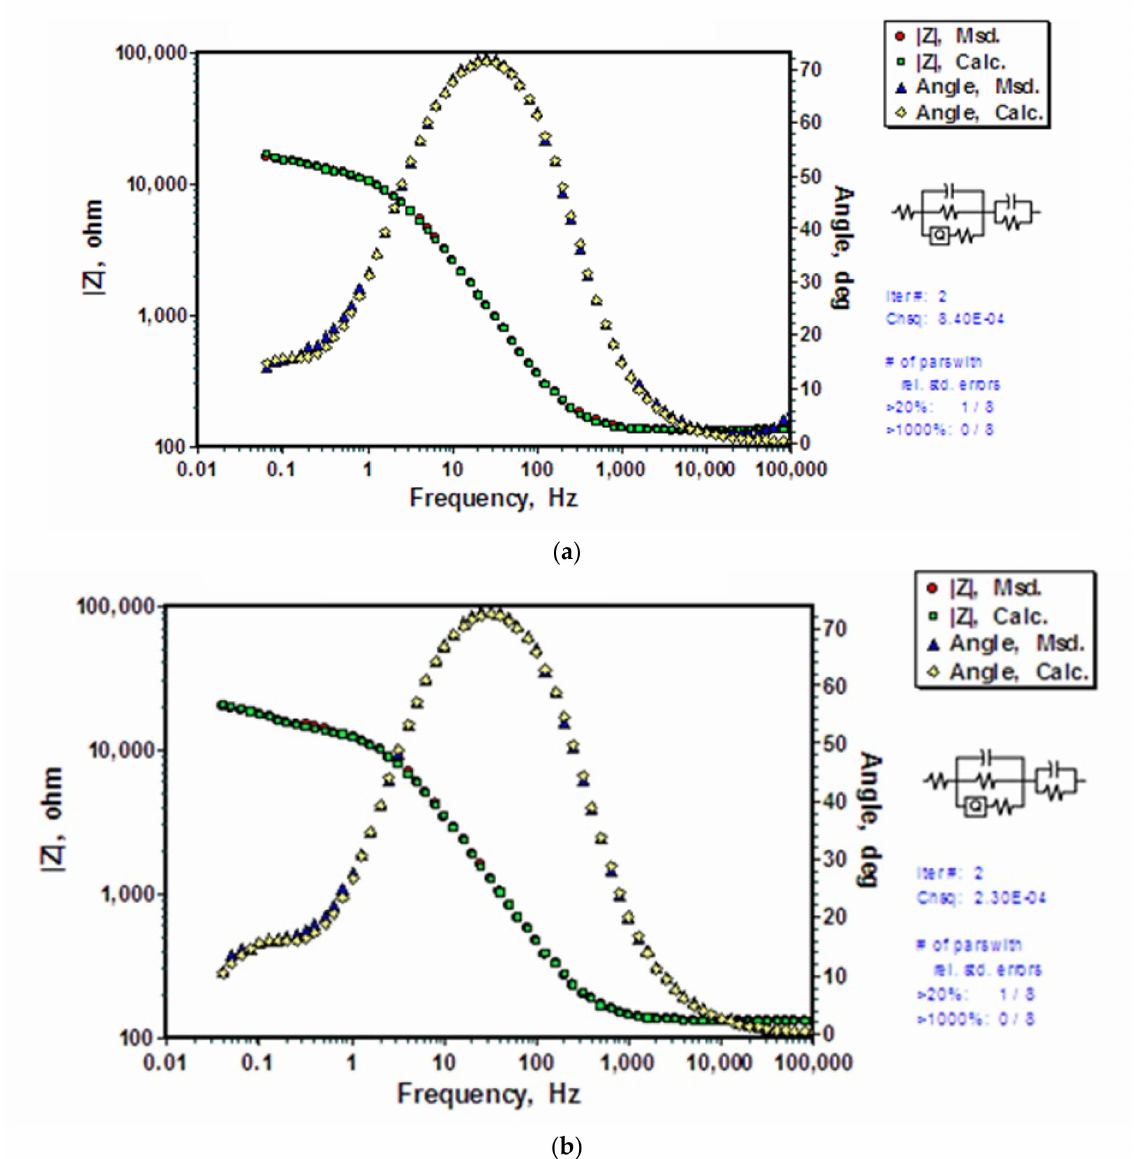
Figure 6. Experimentally measured Bode and phase angle plots and the corresponding data calculated using the electrical equivalent circuit, R s (C Si R Si (Q h R h ))(C dl R dl ) for coated AZ91D alloy exposed to 0.1 M NaCl solution: ( a ) BTSE coating on substrate with no prior alkali treatment, and ( b ) BTSE coating on substrate pre-polarized in